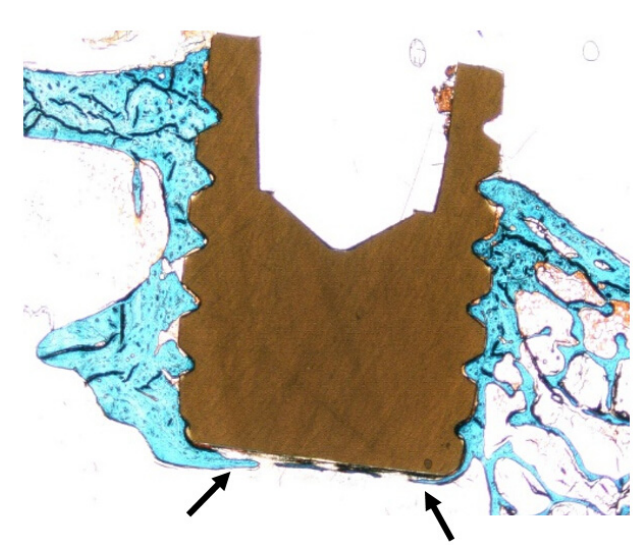
Figure 5. Histologic section of all threads presenting manifest bone ingrowth in all threads, indicative of osteoconductive features of the PEEK material (arrow). This actual section was from an HA-coated implant retrieved 12 weeks after